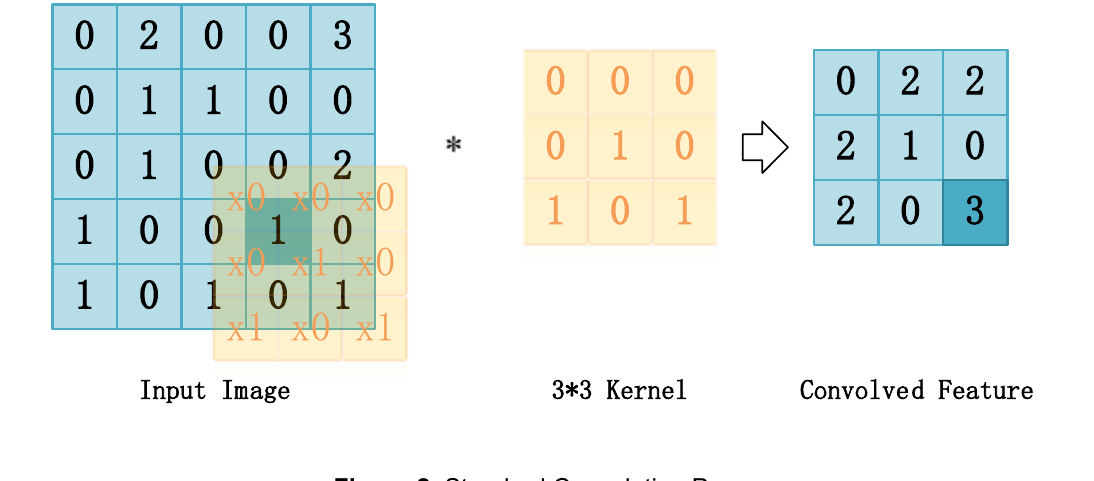
Figure 2. Standard Convolution